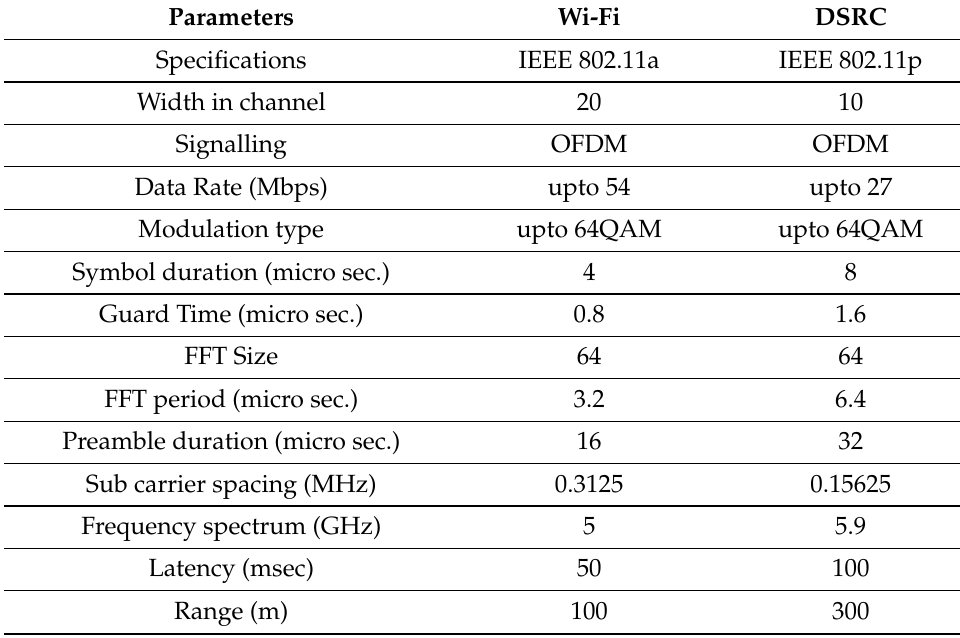
Table 6. Comparison of medium-range